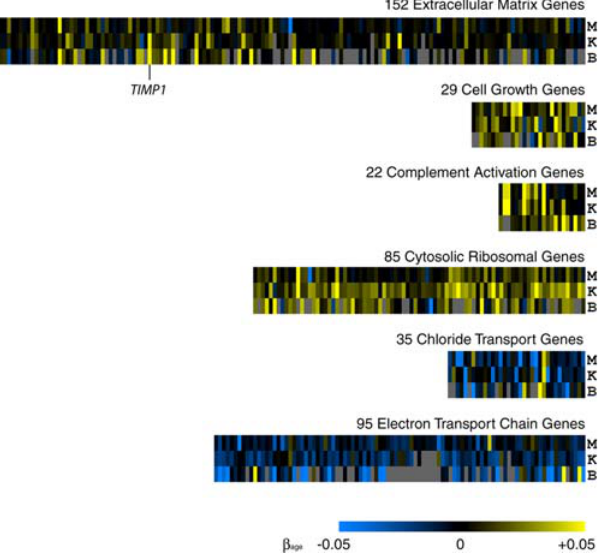
Figure 4. A Common Signature for Aging in Muscle, the Kidney, and the Brain Shown are expression data from sets of extracellular matrix genes, cell growth genes, complement activation genes, cytosolic ribosomal genes, chloride transport genes, and electron transport chain genes. Rows are human tissues (M, muscle; K, kidney; B, brain). Columns correspond to individual genes in each gene set. Scale represents the slope of the change in log 2 expression level with age ( b 1j ). Gray indicates genes were not present in the dataset. A navigable version showing identities of specific genes can be found at http://cmgm.stanford.edu/ ; kimlab/ aging_muscle. DOI: